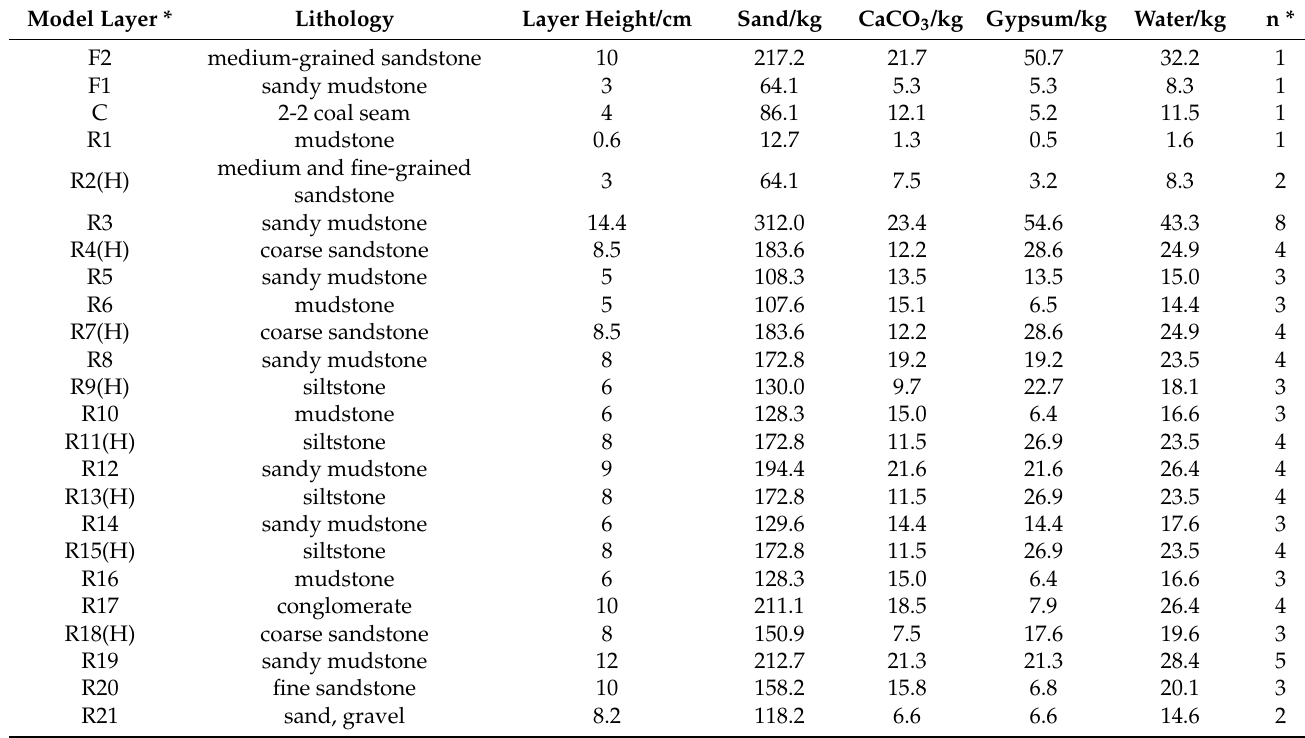
Table 3. Material ratio of physical